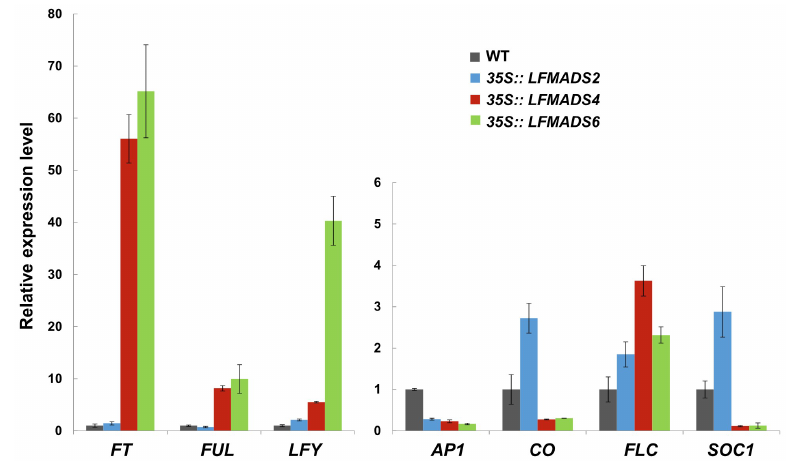
Figure 6. Detection of transcripts for endogenous flowering time genes and floral organ-identity genes in transgenic Arabidopsis overexpressing LFMADS2 , LFMADS4 , and LFMADS6 , respectively. Relative transcription levels of endogenous flowering-related genes in 35S::LFMADS2 , 35S::LFMADS4 , and 35S::LFMADS6 transgenic Arabidopsis were determined by real-time qPCR analysis. Higher expression of FT , FUL and LFY transcripts were detected in 35S::LFMADS4 and 35S::LFMADS6 transgenic lines, while not observed in 35S::LFMADS2 transgenic Arabidopsis compared to the wild-type. All expression levels of genes were normalized against TUB2 expression. Primers used in qPCR reactions are listed in Table S6.